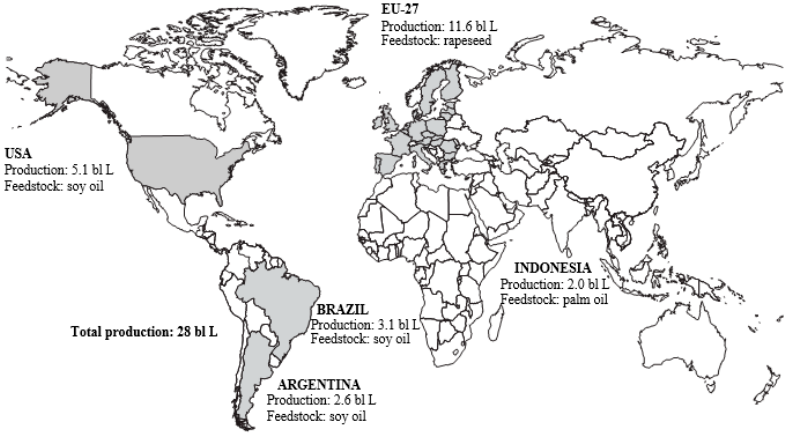
Figure 3. Word biodiesel production, average 2012–2014 [5]. Figure 1. Word biodiesel production, average 2012–2014